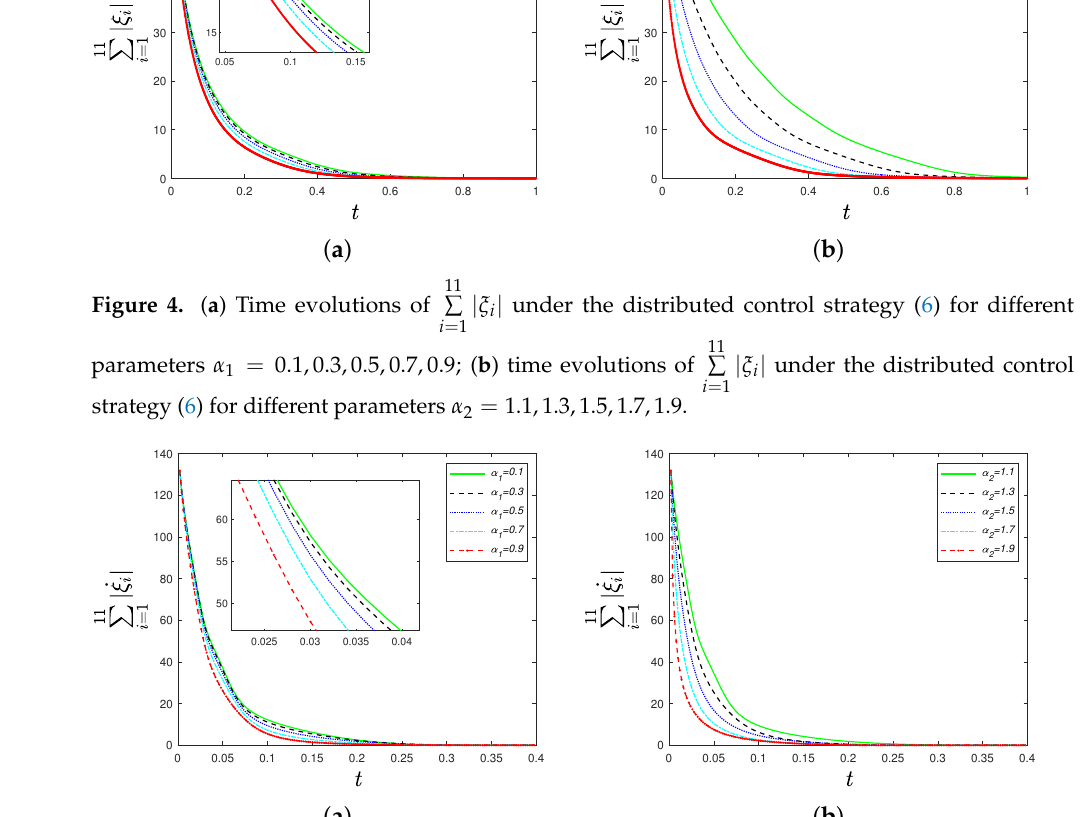
11 ∑ | ˙ ξ | under the distributed control strategy (8) for different i i = 1